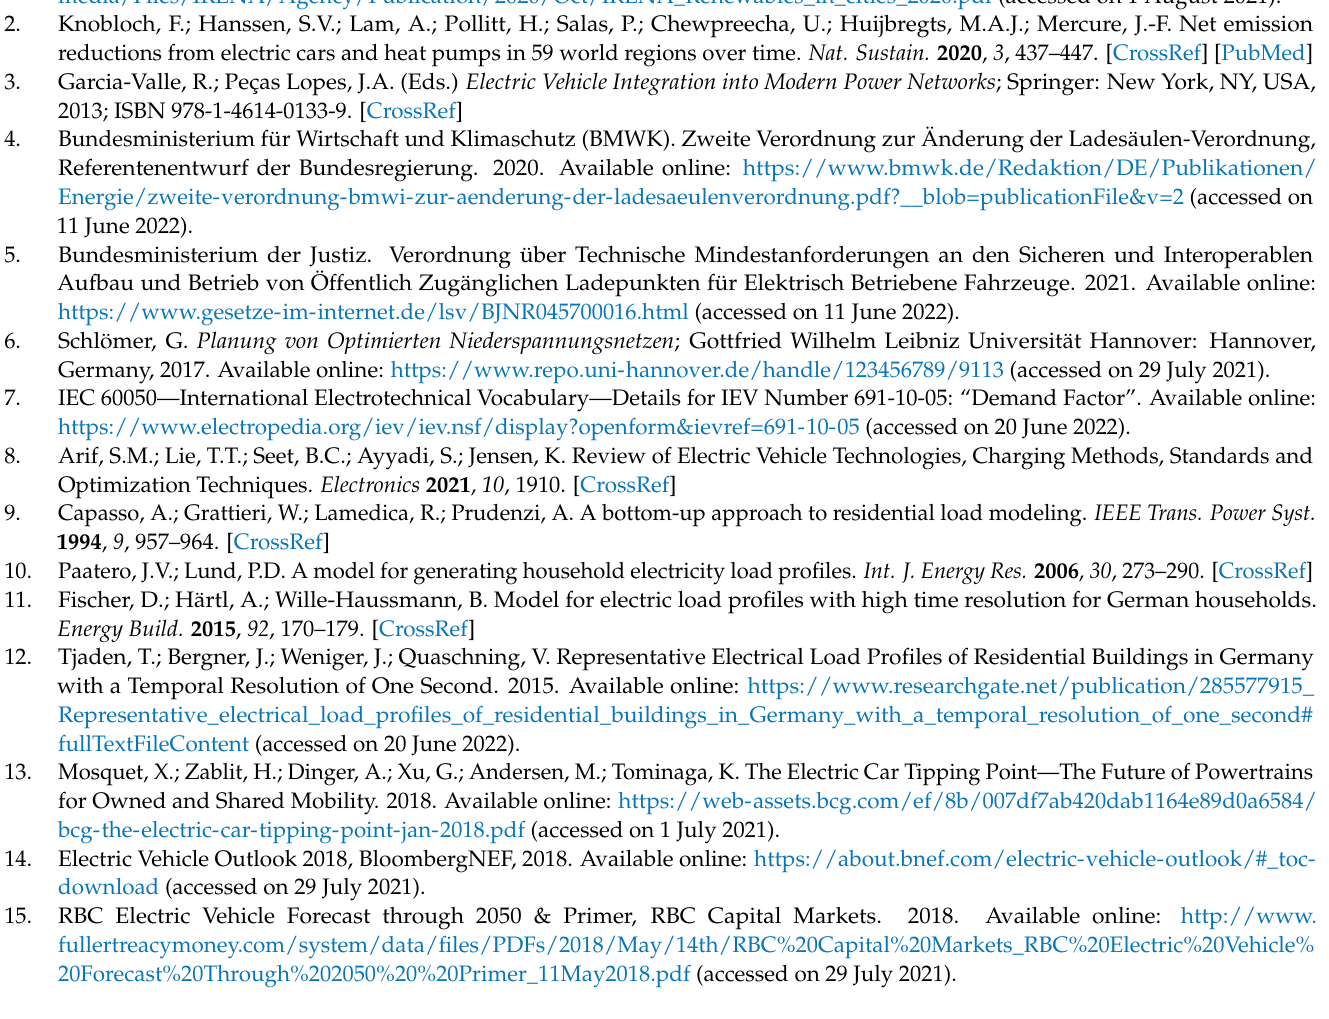
Figure A12. Accumulated charging power in kW for 3.7 kW charging points up to 500 charging points for seven area types.